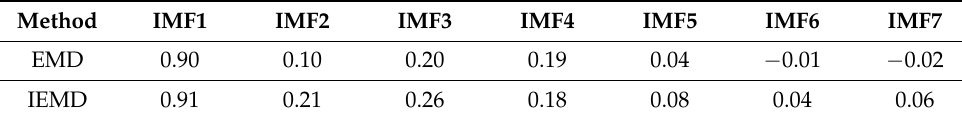
Table 6. Coefficients under different decomposition.